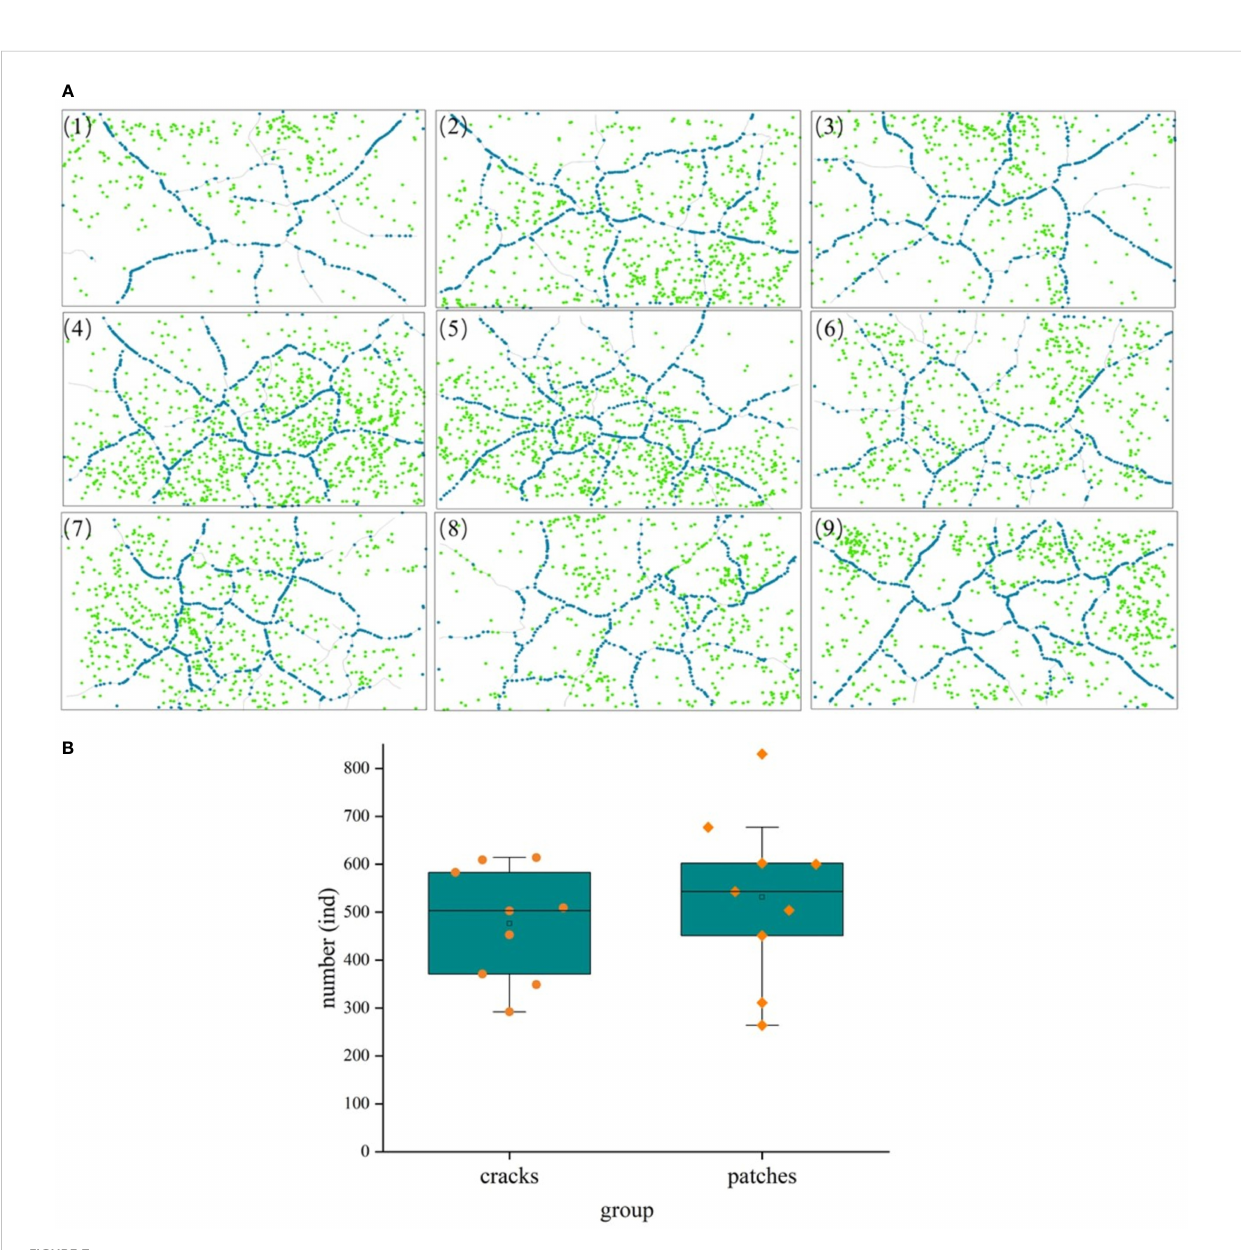
FIGURE 7 A comparison of seedling distribution in mud cracks and patches during the experimental period. (A) Distribution of mud cracks and seedlings in nine parallel samples (1 - 9), blue dots represent individual seedlings in mud cracks, whereas green dots represent seedlings in patches. (B) A comparison of seedling number in mud cracks and